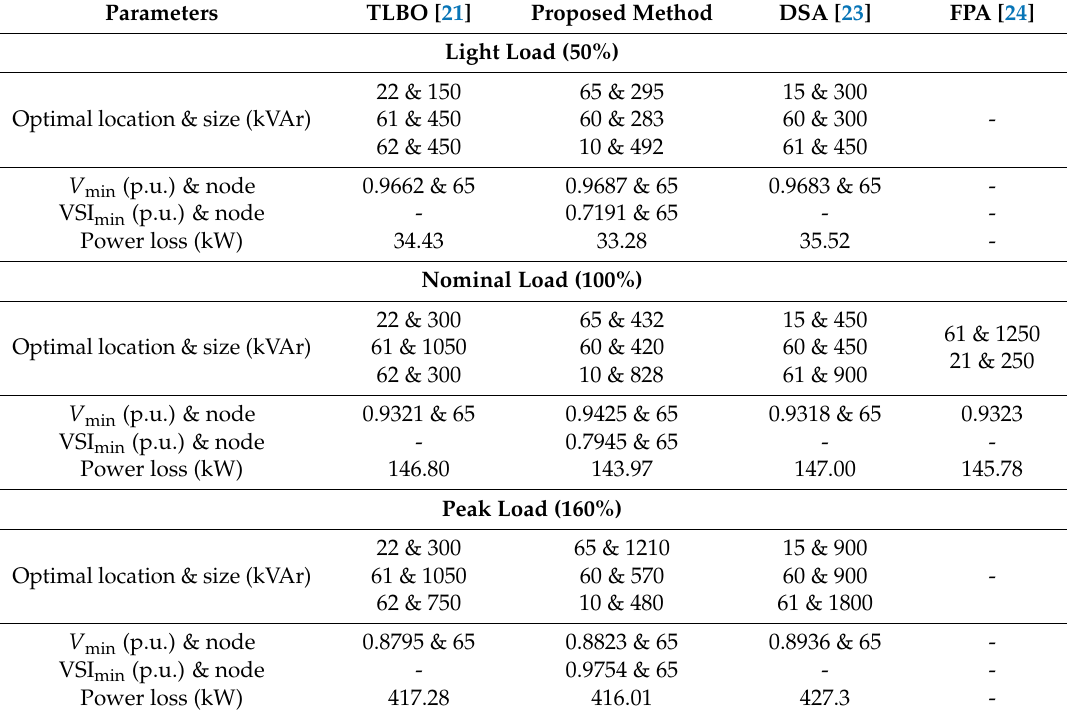
Table 3. Results of the proposed method with TLBO [21], the direct search algorithm (DSA) [23]